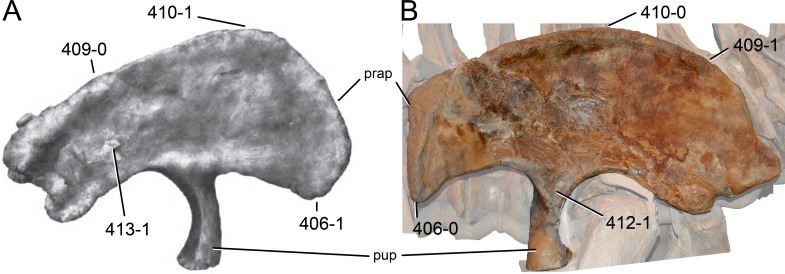
Neosauropod ilia.Right (A) and left (B) ilium of Brachiosaurus altithorax FMNH P25107 (A; modified from Riggs, 1904) and Diplodocus hallorum DMNS 1494 (B) in lateral view. Note the pointed (B; C406-0) or semicircular preacetabular process (A; C406-1), the straight (A; C409-0) or strongly convex dorsal edge (B; C409-1), the location of the highest point (anterior to pubic peduncle, A, C410-1; posterior to pubis peduncle, B, C410-1), the triangular fossa on the pubic peduncle base (B; C412-1), and the tubercle in the postacetabular region (A; C413-1). Abb.: prap, preacetabular process; pup, pubic peduncle. Scaled to same height.